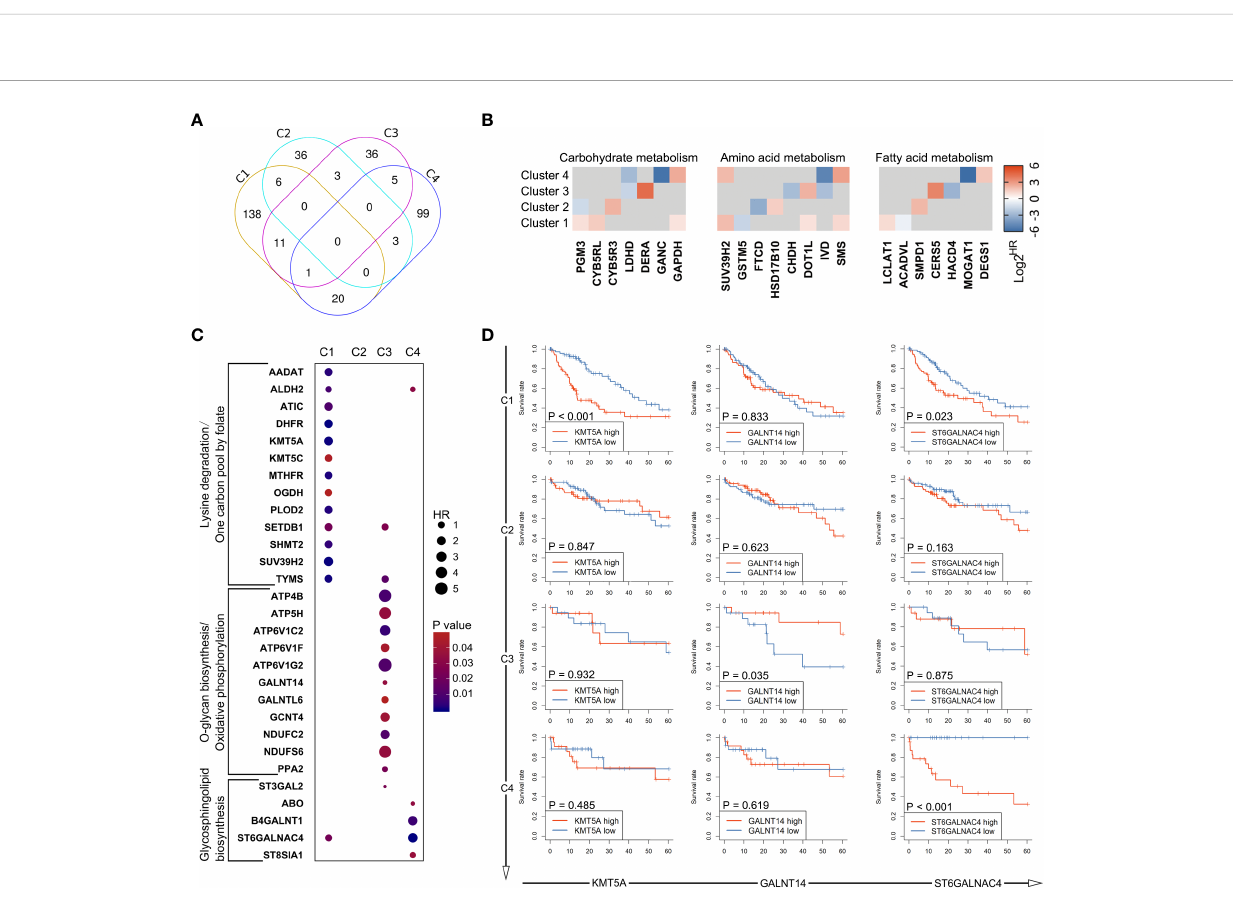
FIGURE 5 Heterogeneity in prognostic signi fi cance of metabolic genes strati fi ed by the metabolic subtypes. (A) A venn diagram showing common and speci fi c prognostic genes across four subtypes. (B) The hazard ratio values (HRs) of prognostic genes involved in glucose metabolism, amino acid metabolism, and fatty acid metabolism are depicted in heatmap. Only HRs of genes with signi fi cant prognostic signi fi cance are shown. (C) Dot plot depicting the prognostic genes involved in unique metabolic pathways described in Figure 4B. (D) Several genes were selected from (C) , including KMT5A, GALNT14, and ST6GALNAC4. Survival curves showing the predictive role of these genes for over survival in each subtype.